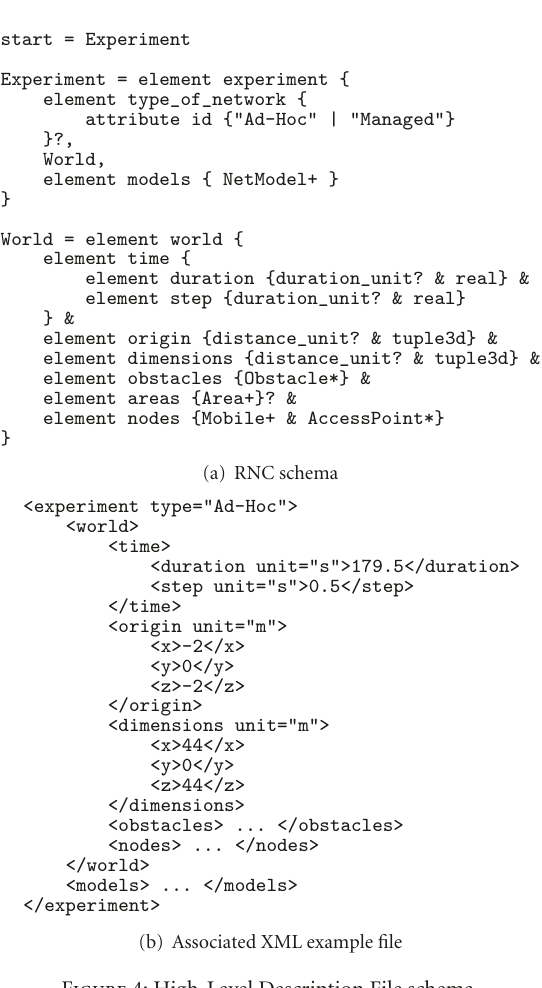
Figure 4: High-Level Description File schema.